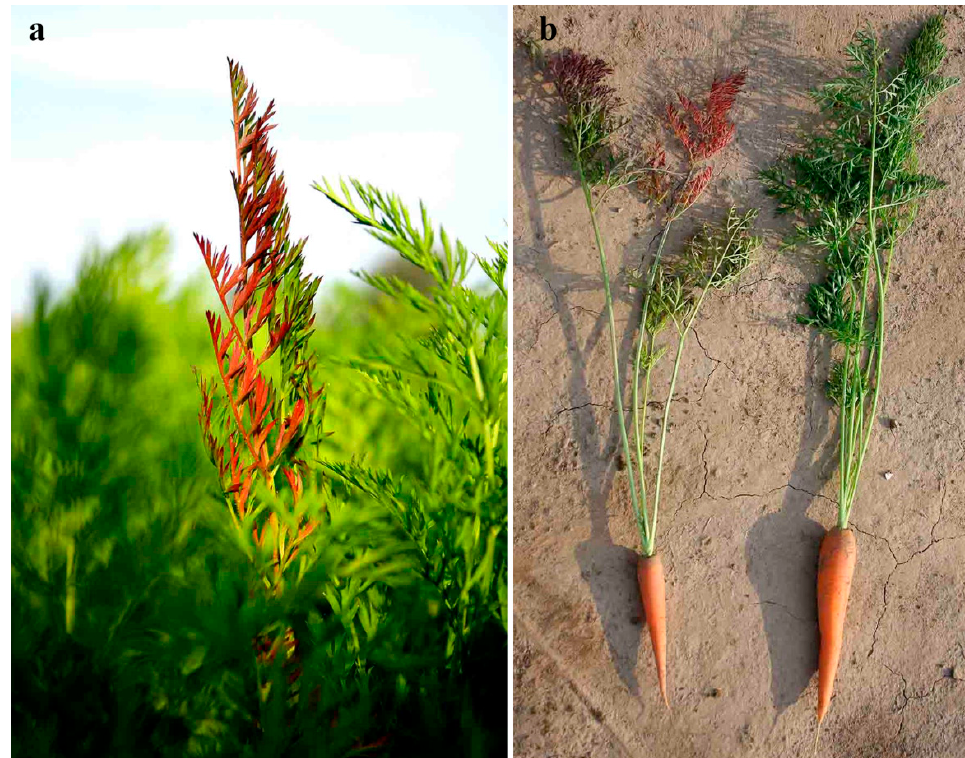
Figure 1. Symptoms of Ca. Phytoplasma solani on carrot plants ( a ) leaves with intensive red color ( b ) diseased plant (left) and healthy plant (right). During the colelection of carrot samples (end of June, beginning of July), climatic conditions (temperature, rainfall) did not contribute to the disease incidence, although they were different in both years. During June and July, average temeratures in 2016 (21.7 °C and 23.3 °C, respectively) were lower than in 2017 (23.0 °C and 23.8 °C, respectively) and precipitations in 2016 (143.2 mm and 68.4 mm, respectively) were higher than in 2017 (65.7 mm and 12.0 mm, respectively) (Figure 2).